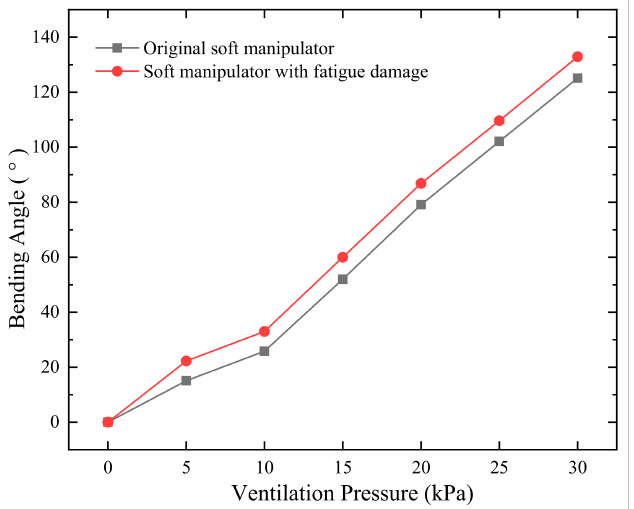
Figure 13. Comparison of original soft manipulator and soft manipulator with fatigue